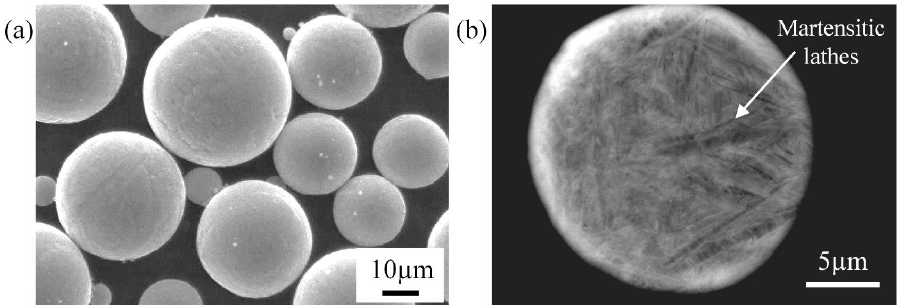
Figure 1. SEM images of ( a ) Ti64 powder (grade 23) and ( b ) cross-section of a Ti64 particle under back-scattered